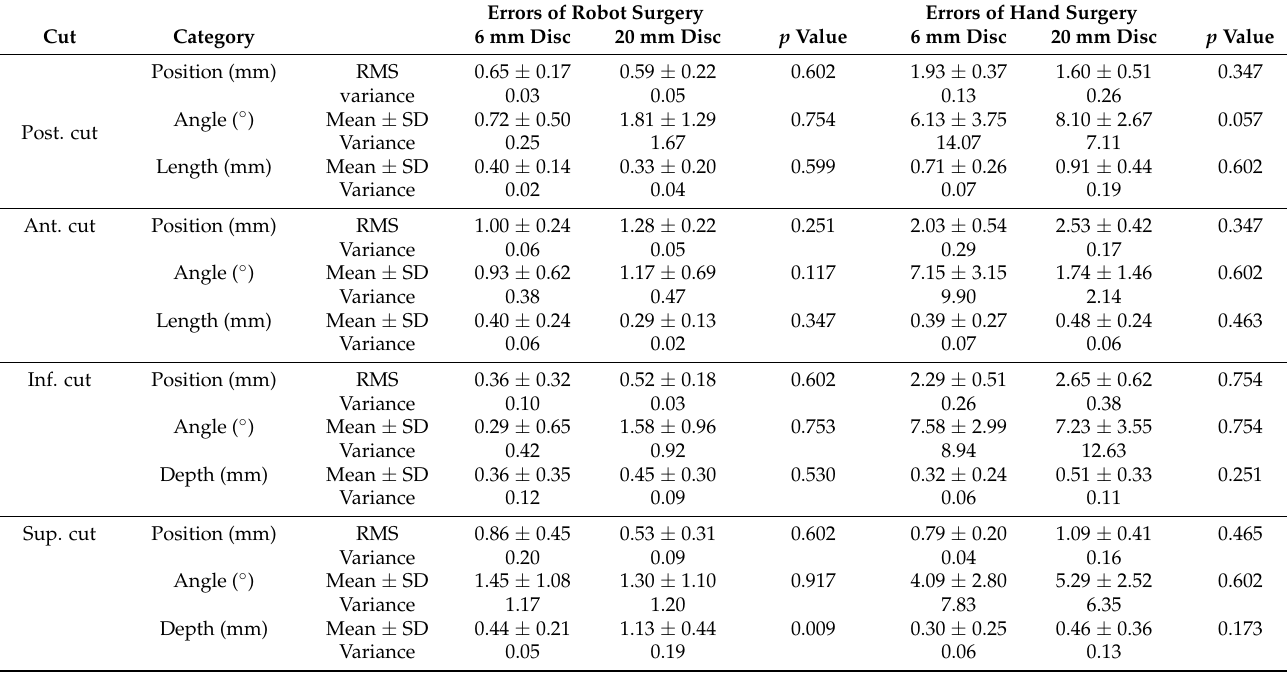
Table 3. The absolute mean values of osteotomy errors for position, angle, length and depth on mandible phantoms categorized by 6 mm disc and 20 mm disc in the robotic surgery group and the 6 mm disc and 20 mm disc in the manual surgery group.